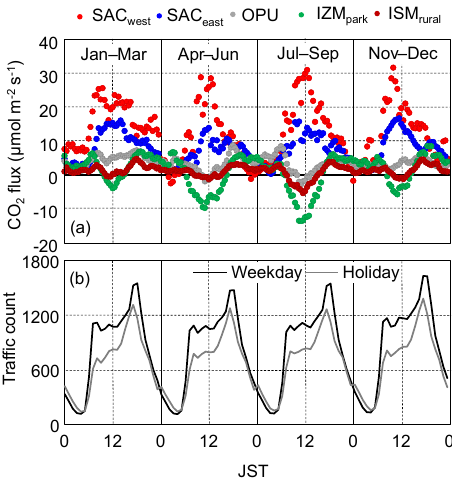
Figure 4. Mean diurnal variations in (a) CO 2 fluxes and (b) traffic count at two highway exits within the flux footprint of SAC west. The diurnal patterns were created every consecutive 3 months in 2015. Because measurements at IZM began in February 2015, di- urnal variations for IZM during the period from January to March were calculated based on data from February and March in 2015 and January in